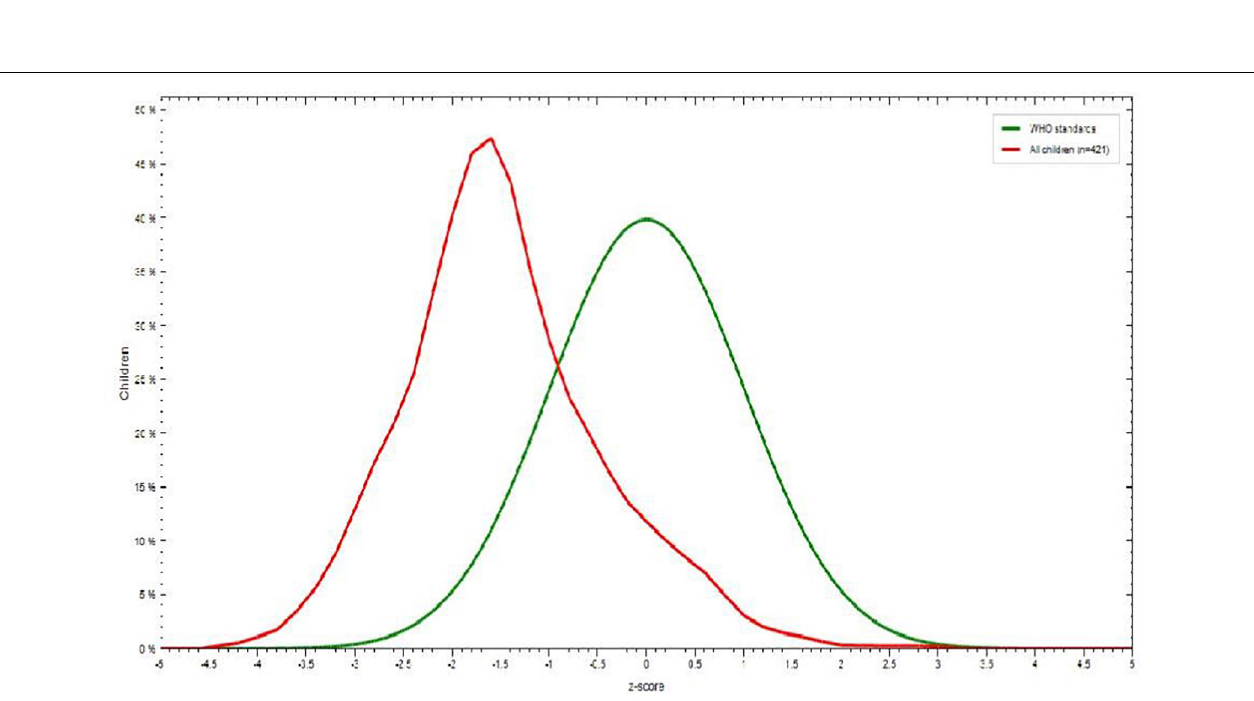
FIGURE 2 | Weight-for-age Z score among children aged 6–23 months in Dessie town, Northeastern Ethiopia, 2021.